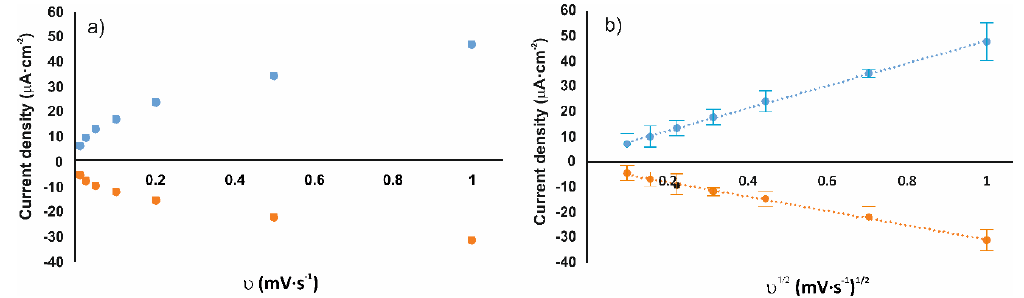
Figure 5. Analysis of the dynamic behavior of the sensor based on the mixture AuNP tOcBr /ZnPc R -S-ZnPc R ( a ) Laviron model, graphical relationship between the current peak density and the sweep rate ( ν ), ( b ) Randles – Sevcik model peak current density varies linearly with the square root of the scan rate ( ν 1/2 ). Table 1. Relationship between the intensity of the peaks and the scan rate in sensors immersed in 10 − 4 mol·L − 1 catechol. (Results shown correspond to the average values obtained from three different experiments).